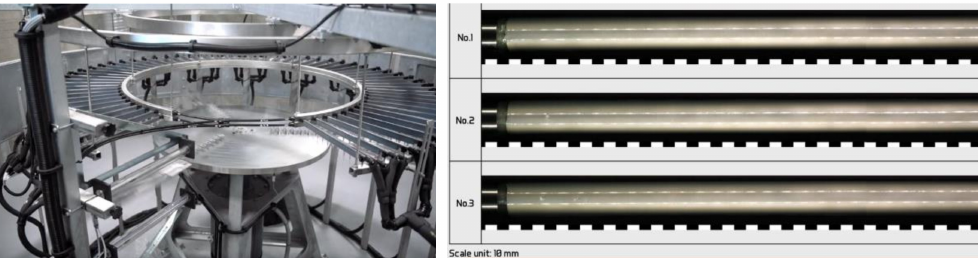
Figure 15. Rain erosion test facility and three specimens used at PolyTech Test and Validation A / S according to DNV-GL-RP-0171 [38], for the analysis and experimental validation.